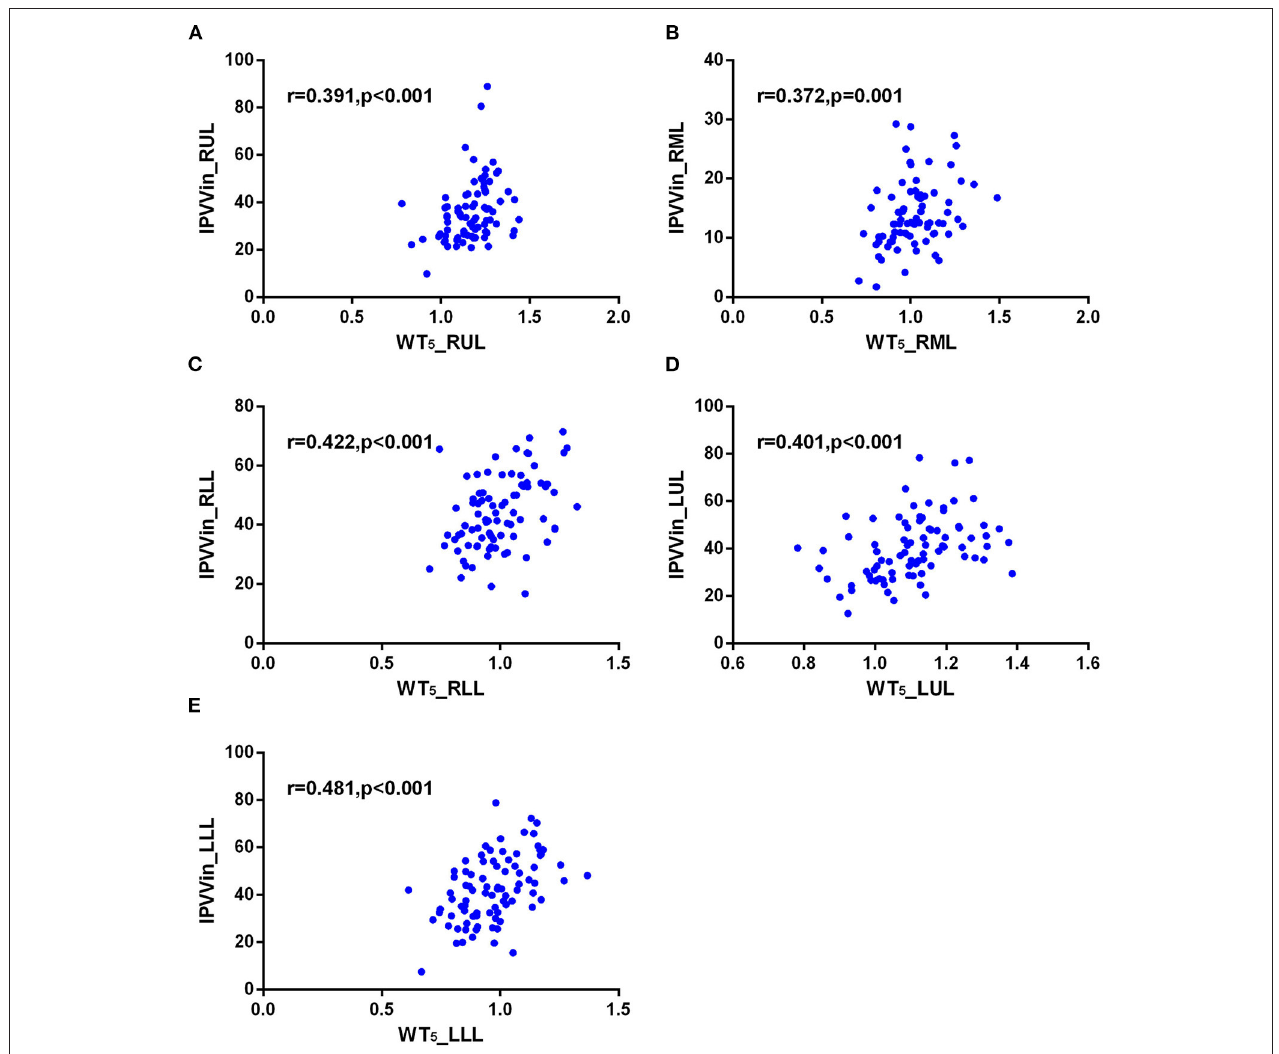
FIGURE 5 | Correlations of IPVV in individual lobes with WT 5 in the inspiratory CT scan. (A) RUL; (B) RML; (C) RLL; (D) LUL; (E)